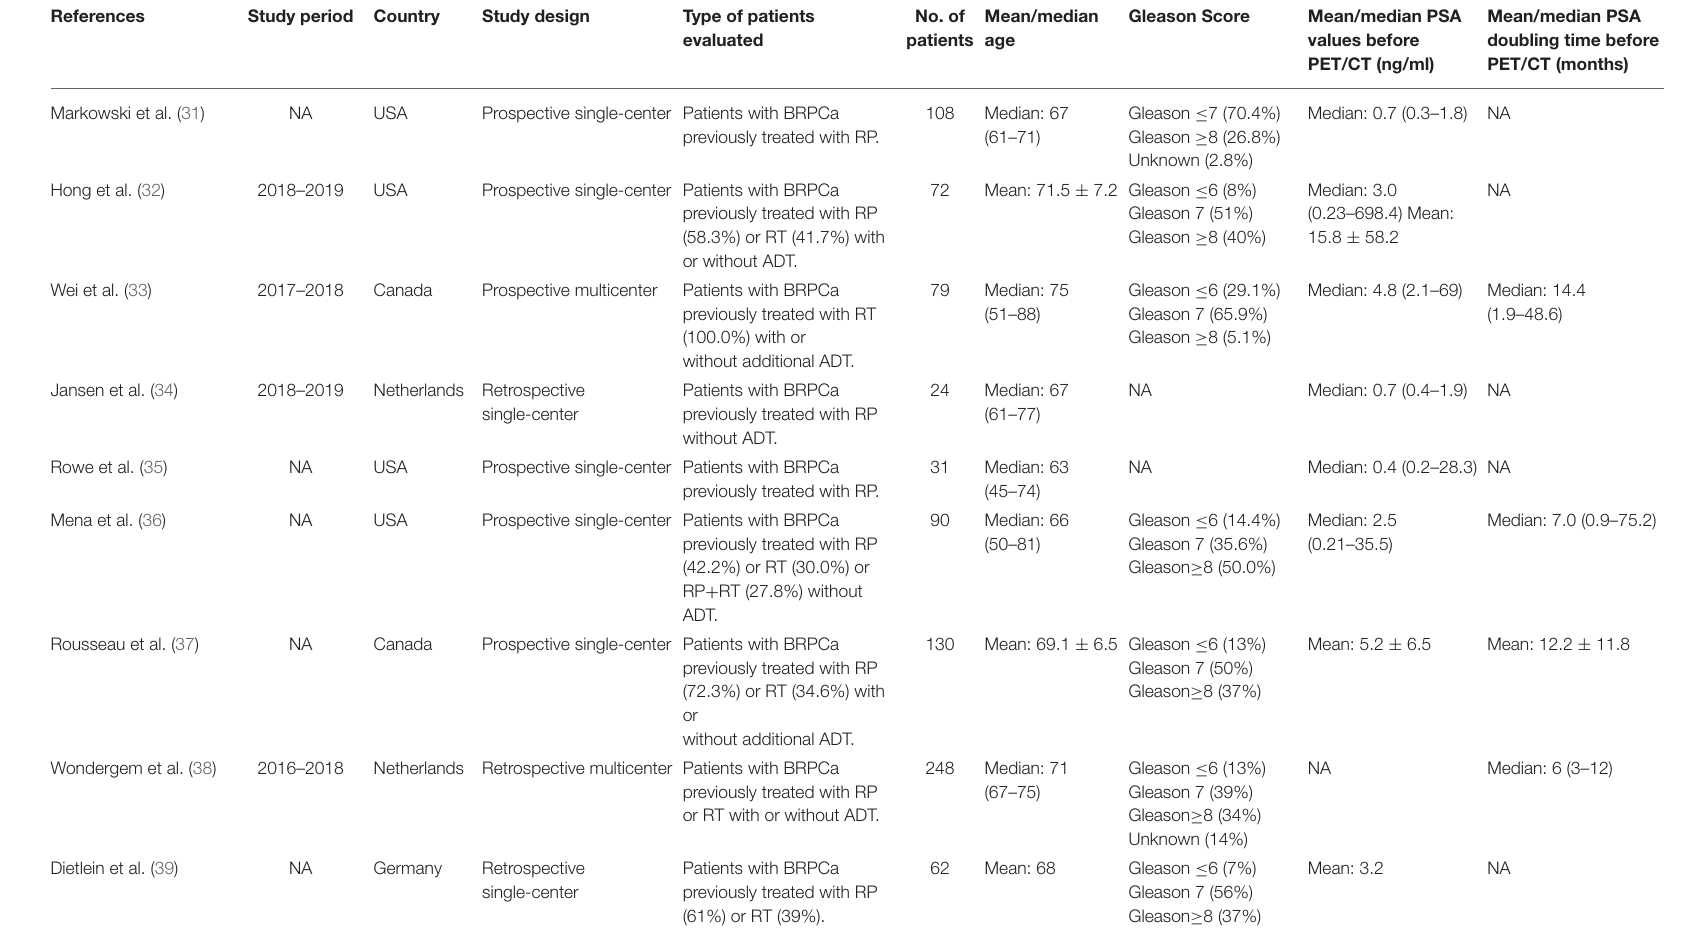
TABLE 1 | Summary of the included